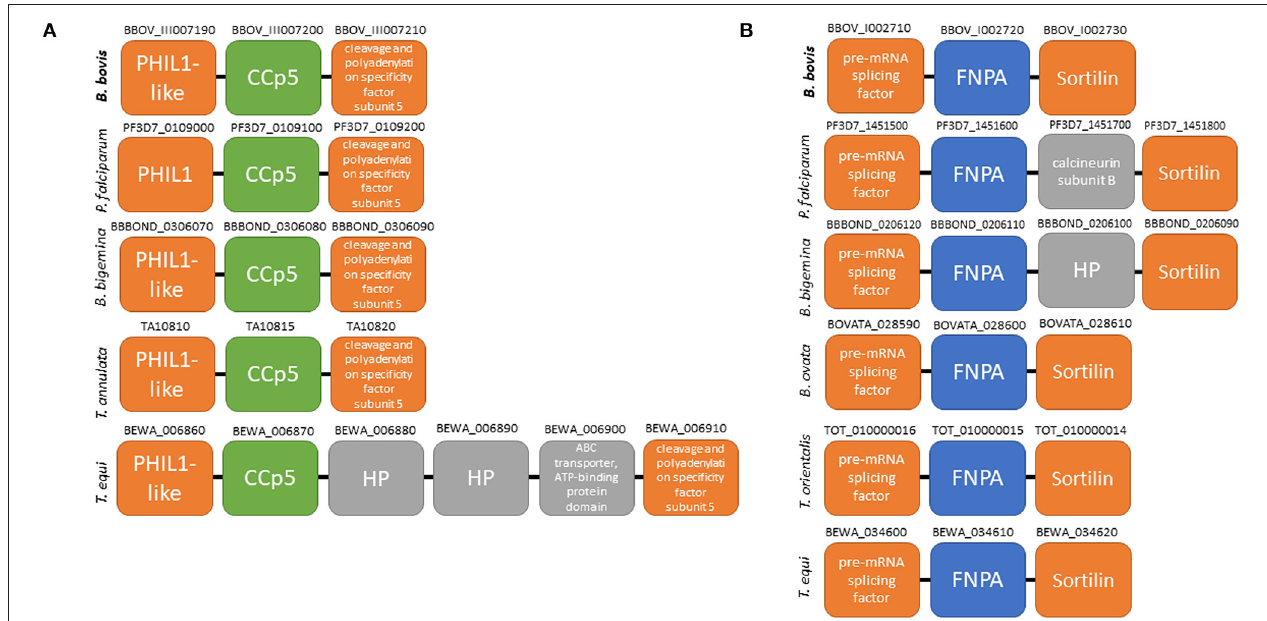
FIGURE 1 | Schematic representation of gene localization and synteny maps of the B. bovis CCp5 (A) and FNPA (B) genes (bold) among several piroplasm species.